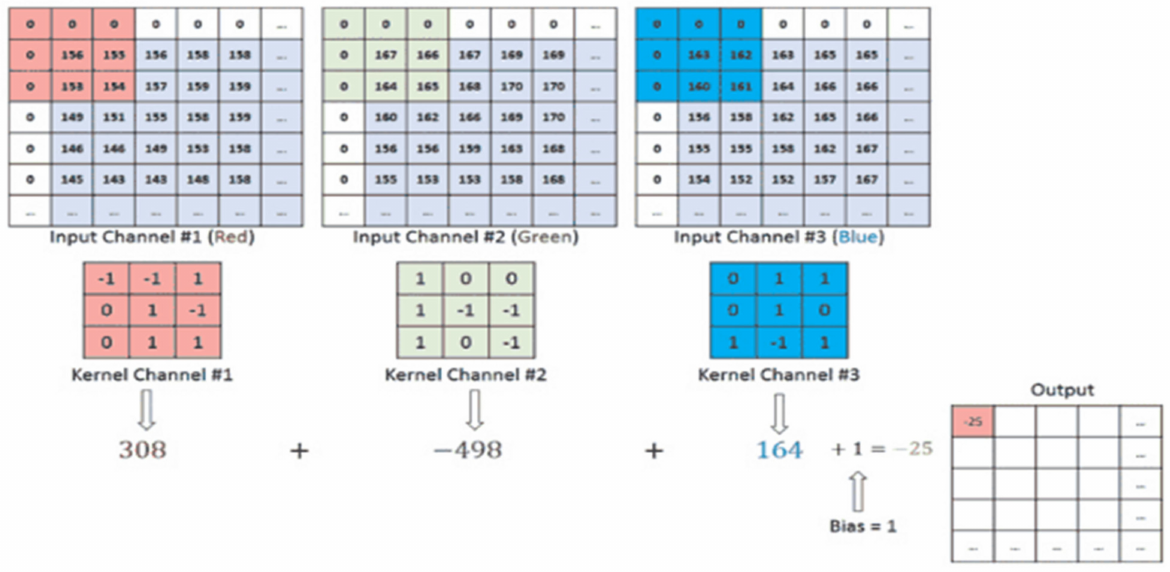
Figure 7. Matrix